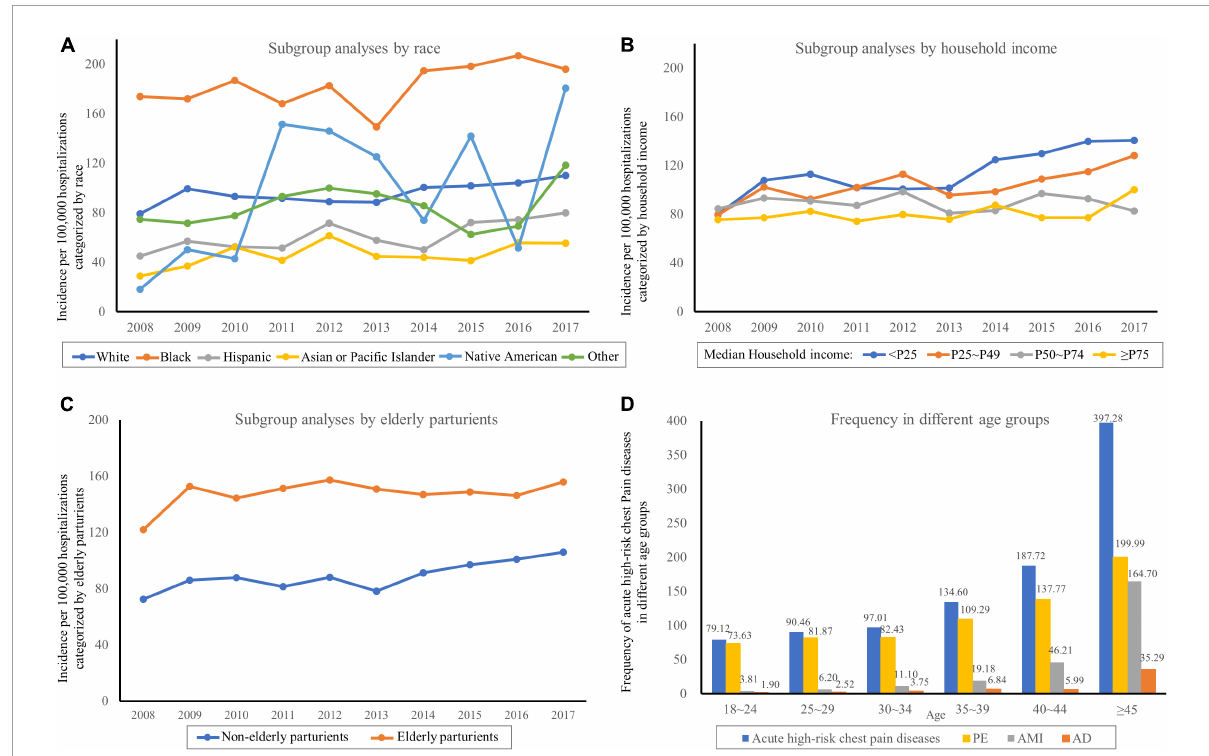
FIGURE3 Temporal trends of acute high-risk chest pain diseases in Subgroups. (A) Subgroup analyses categorized by race. (B) Subgroup analyses categorized by household income. (C) Subgroup analyses categorized by elderly parturients. (D) The incidence increased with age.